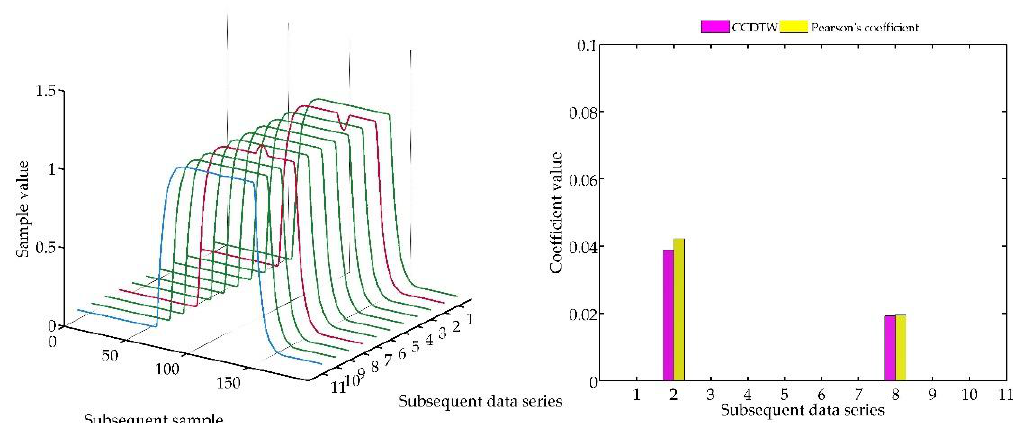
Figure 22. Simulation results obtained for disturbed charts № 2 and № 8 for r ampl = 100.